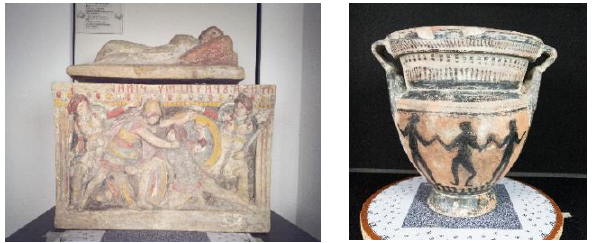
Figure 1: Salinas Archaeological Museum of Palermo. Etruscan Urn (II century b.C.), belonging to the Casuccini collection, on the left. A black-figure Krater (19th century), belonging to the San Martino collection, on the